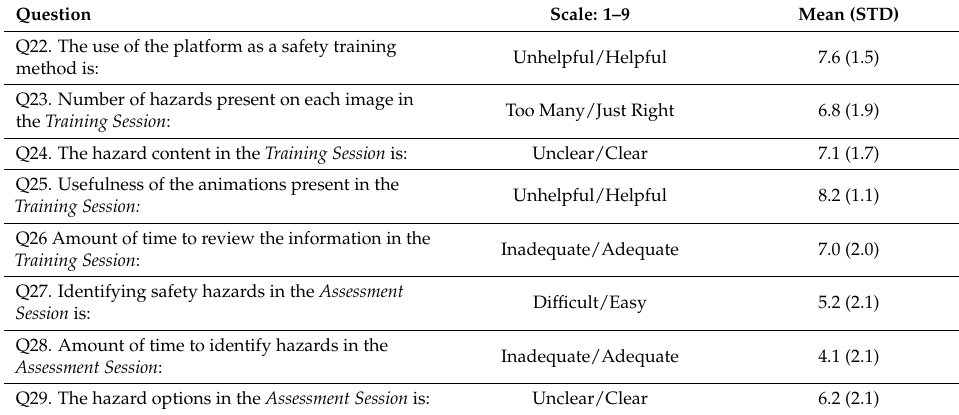
Table 8. Results of QUIS Part 5—Hazard Identification Using the